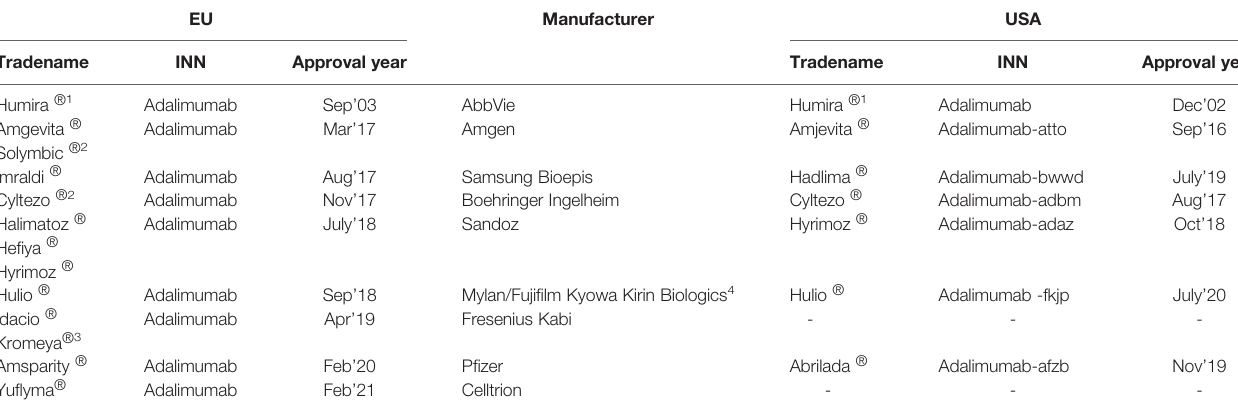
TABLE 1 | Adalimumab products (originator and biosimilar) currently authorized in Europe and USA.